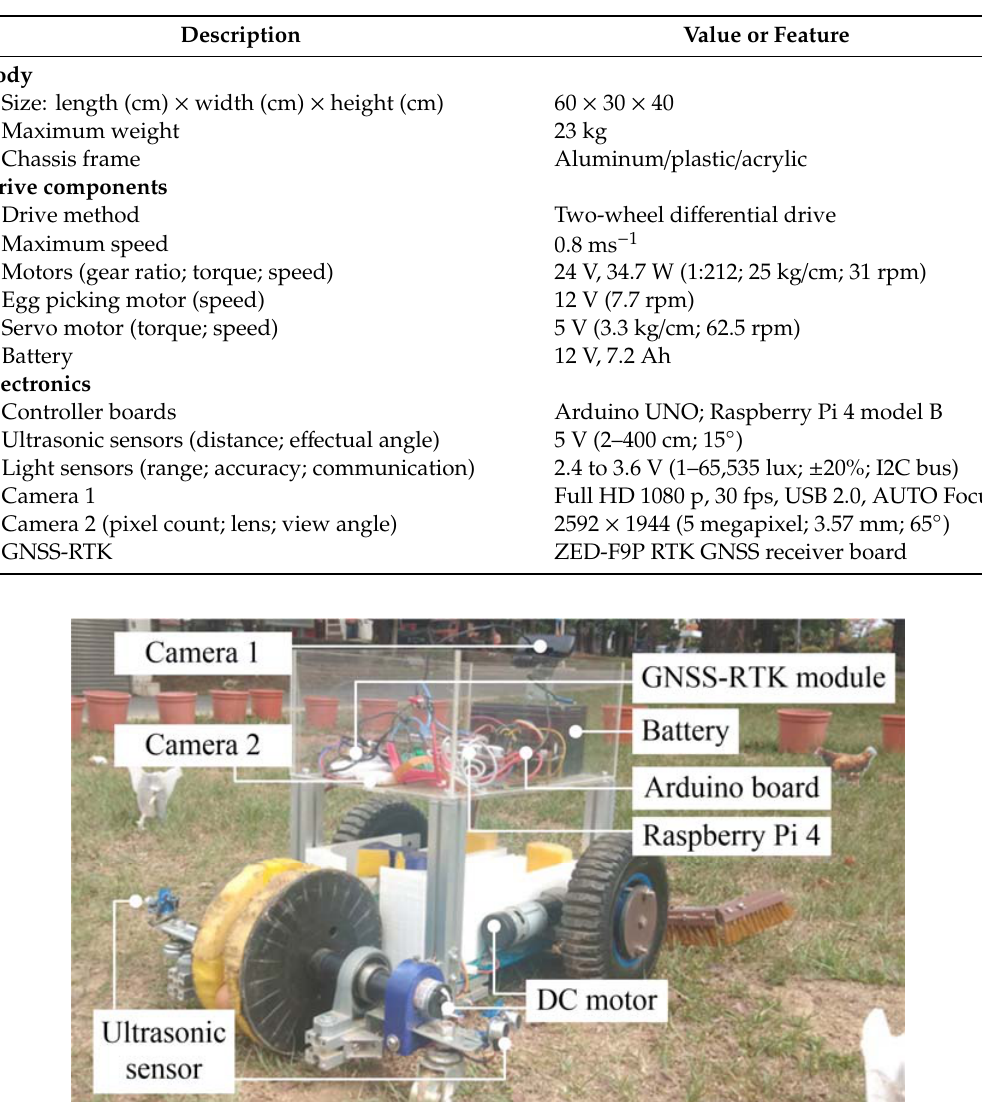
Table 1. Component specifications for the poultry robot.